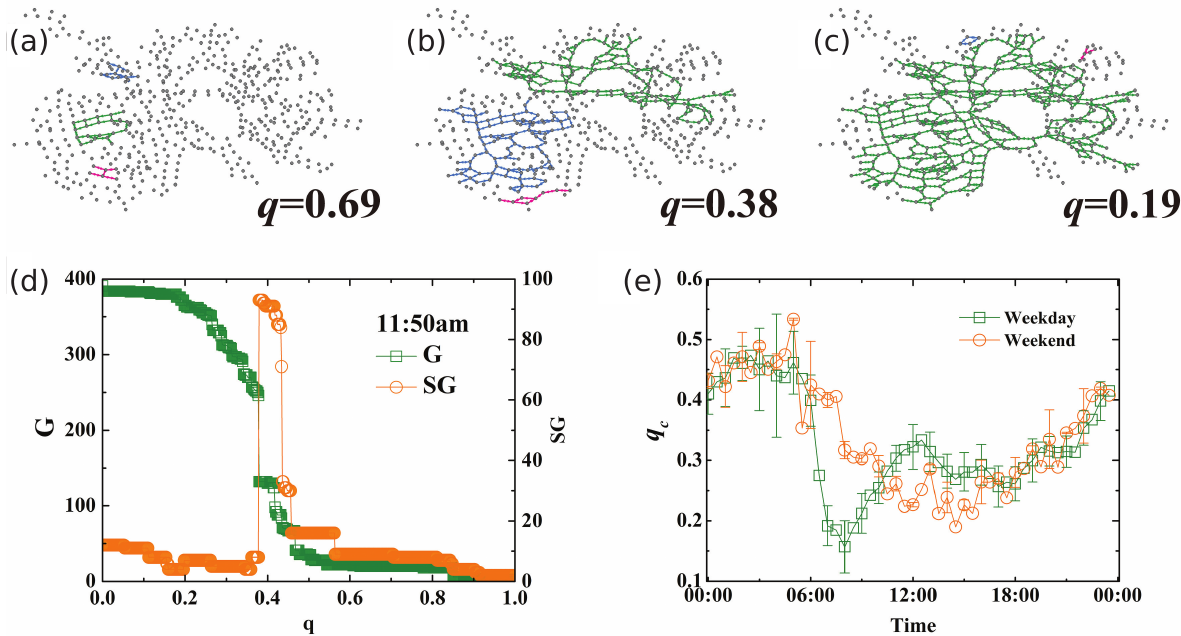
Figure 9. Percolation of traffic networks. Traffic networks for three q values corresponding to different connectivity states. ( a )–( c ) exhibit the traffic networks under different q values with 0.69, 0.38 and 0.19 representing the states of high-, medium- and low-velocity thresholds, respectively. For clarity, only the largest three clusters are plotted, which are marked in green (largest cluster), blue (second largest cluster) and strawberry (third-largest cluster). Here, the clusters are strongly connected components. ( d ) The size of the largest cluster (G) and the second largest cluster (SG) of traffic networks as a function of q . Critical value q is determined as the q value when SG becomes maximal. ( e ) q c time, averaged separately over nine weekdays and two weekends. After